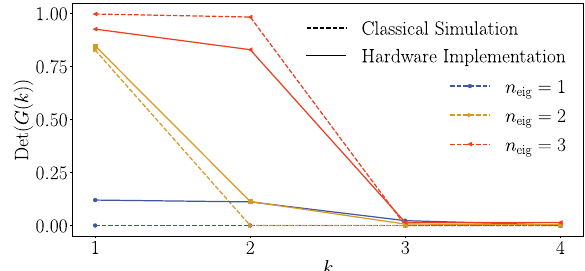
Fig. 2 Gramian Determinant Calculation. Here we plot the determinant of the Gramian matrix, Det ð G Þ , for G measured on the Honeywell quantum computer (solid) and simulated classically (dashed) for a 2-qubit XY spin chain. Speci fi cally we looked at states with non-zero overlap with k = 1 (blue), k = 2 (yellow) and k = 3 (red) eigenstates. For both sets of data Det ð G ð n eig ÞÞ (cid:4) 0 , demonstrating the effectiveness of the method for determining n eig that we introduce in Section “ Calculating n eig ” . For the Honeywell imple- mentation we used 1000 measurement samples per circuit.